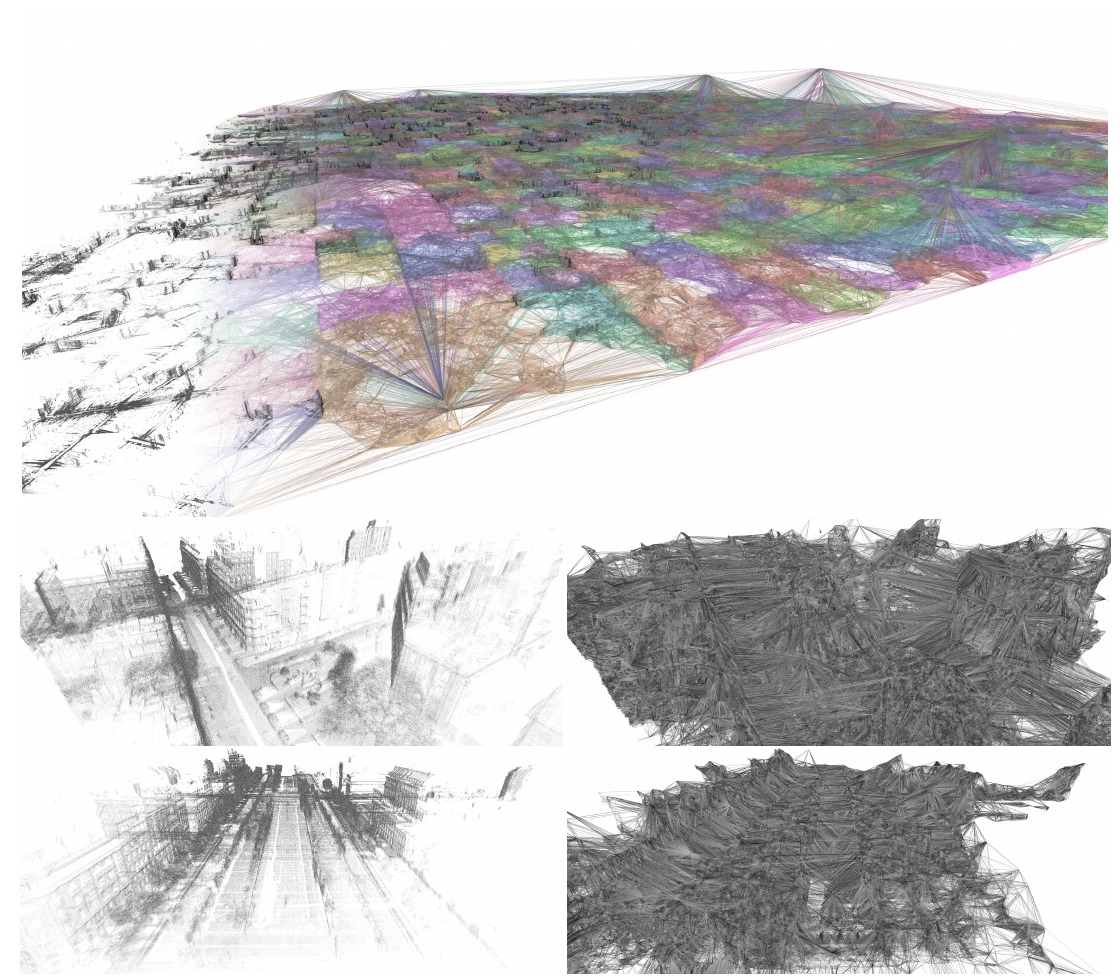
Figure 7. Result of the proposed approach on 1.98 billion of points 6 km 2 with 2 cm spatial resolution. First line: the whole scene. Only finalized cells during the last step are shown. Triangles of the same tile have the same color. Second and third line: two tiles, only local finalized simplex at the first step are shown.